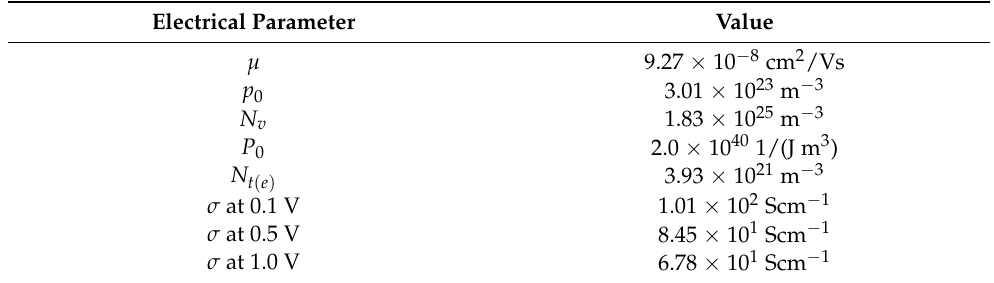
Table 4. Electrical properties under ambient illumination for FcPF 6 :DAAQ/nylon(ZnPc) device. Electrical